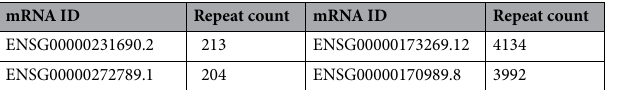
Table 4. Top miRNAs and mRNAs based on repeat count in early-stage and late-stage